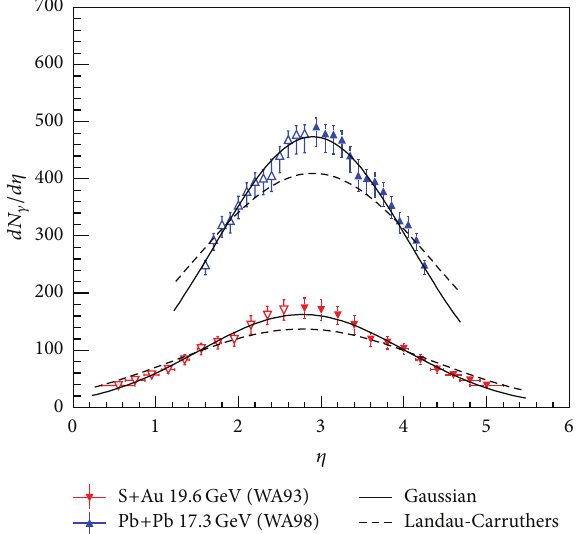
Figure 27: Photon multiplicity distributions of Pb+Pb collision system as a function pseudorapidity for the most central events for different collision